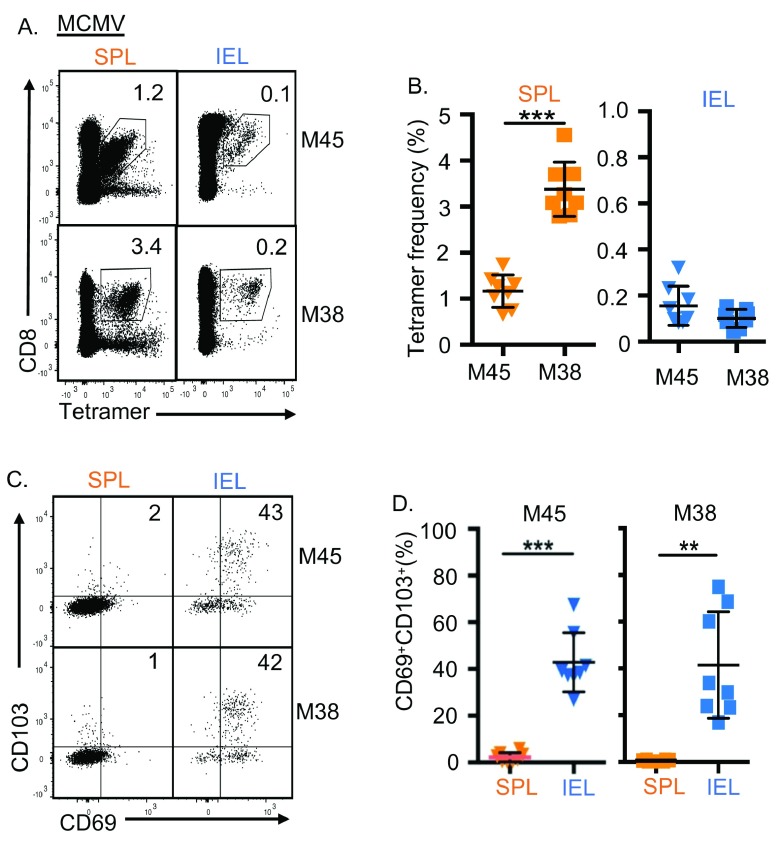
MCMV-specific CD8
+ T-cells in gut intra-epithelium display features of tissue-residency.(
A–D) C57BL/6 mice were infected i.v. with 10
6pfu MCMV, and spleen (SPL, orange), and gut intraepithelial lymphocytes (IEL, blue) sampled 28 days post infection (dpi). Data from two independent experiments is shown. (
A) Composite FACS plots (n=5) of M45- and M38-tetramer staining of live CD4
- lymphocytes showing mean tetramer
+ CD8
+ T-cells (n=8). (
B) Mean (±SD) tetramer
+ CD8
+ T-cells (n=8). (
C) Composite FACS plots (n=5) of expression of CD69 and CD103 on tetramer
+ CD8
+ T-cells showing mean CD69
+CD103
+ tetramer
+ CD8
+ T-cells (n=8). (
D) Mean (±SD) CD69
+CD103
+ tetramer
+ CD8
+ T-cells (n=8). p=0.05-0.011 (*), p=0.01-0.001 (**), p<0.001 (***) by t-test.